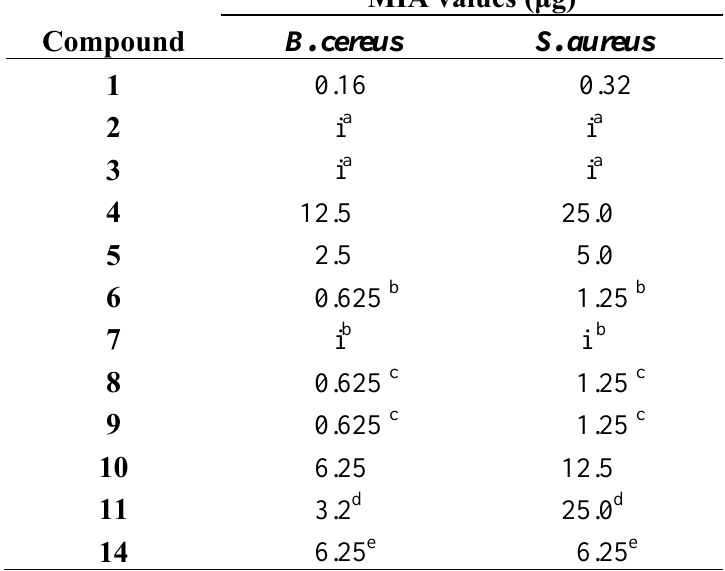
Table 1. Minimum inhibitory amounts (MIA) of terpenoids against Bacillus cereus and Staphylococcus